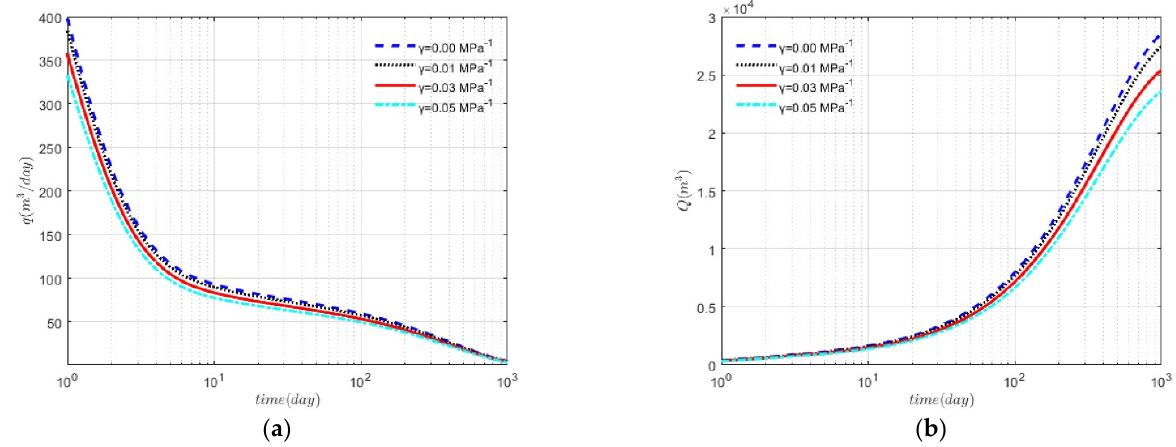
Figure 9. The effect of the stress sensitivity coefficient on productivity: ( a ) effect of the stress sensitivity coefficient on well production rate; ( b ) effect of the stress sensitivity coefficient on cumulative production rate.